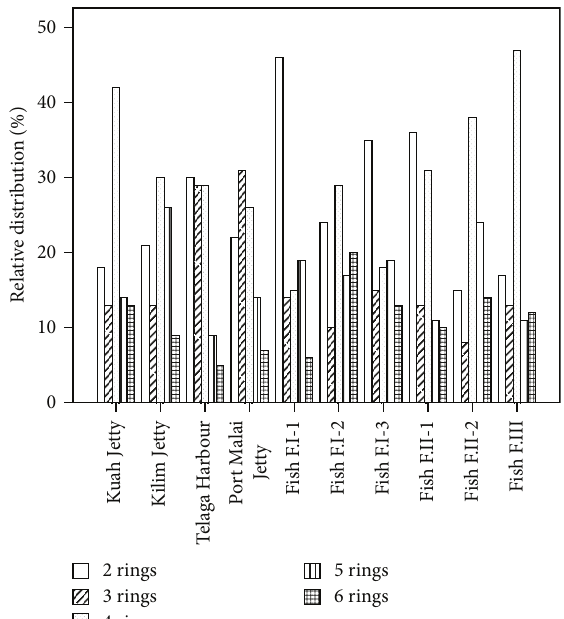
Figure 2: Relative distribution (%) of 2-, 3-, 4-, 5-, and 6-ring PAHs in the sediment samples of Langkawi Island.